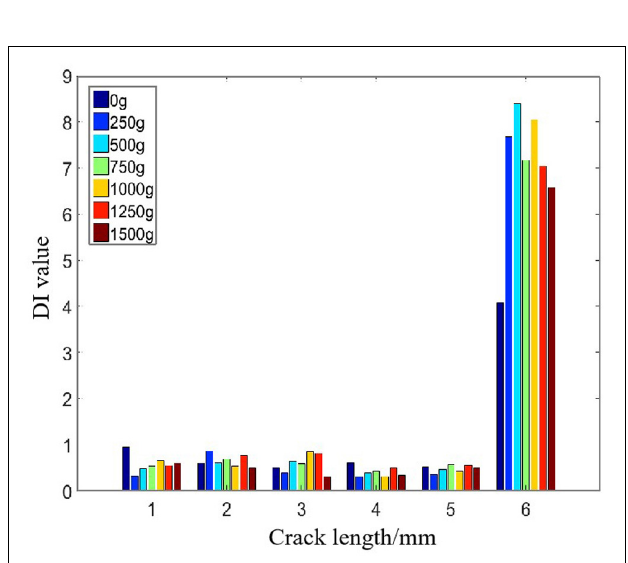
FIGURE 8 | The effect of load and crack length on the guided wave damage imaging.